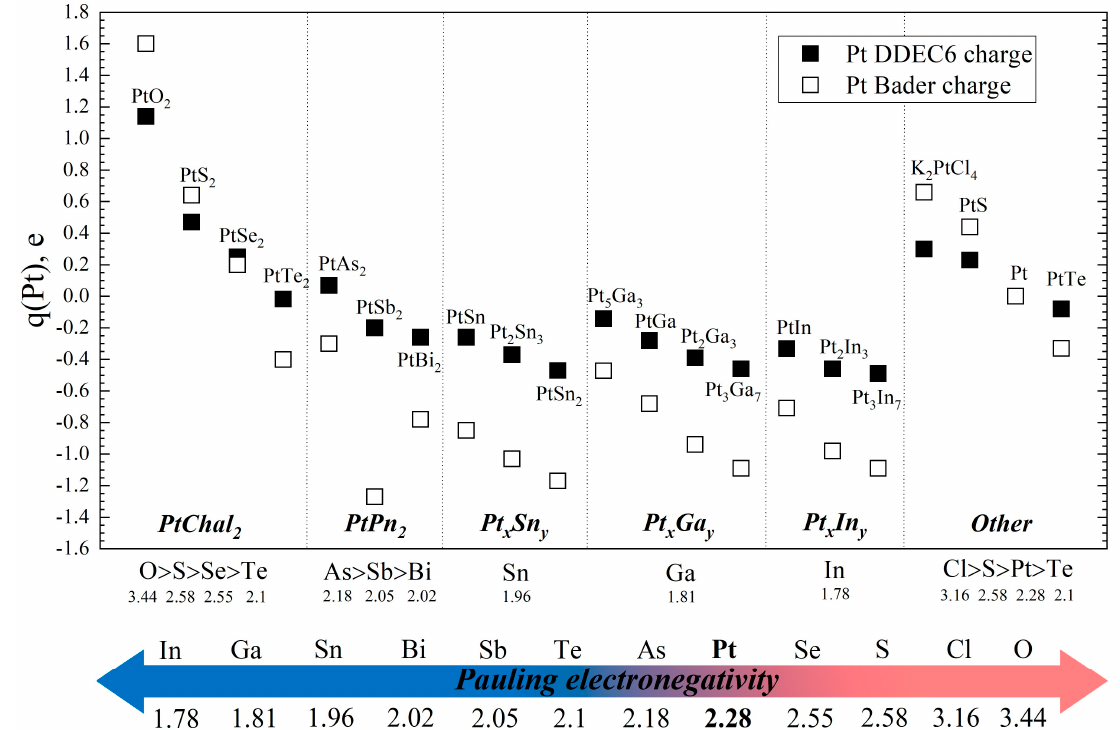
Figure 1. The DDEC6 and Bader QTAIM partial atomic charges for different compound groups. The substances in each group are ordered so that the DDEC6 charge decreases rightward. Symbols show the Pt partial charge calculated using QTAIM and DDEC6 methods. The electronegativity of ligands in each group of compounds is indicated in X axis. The total electronegativity scale for all studied elements is given at the bottom ([3]).